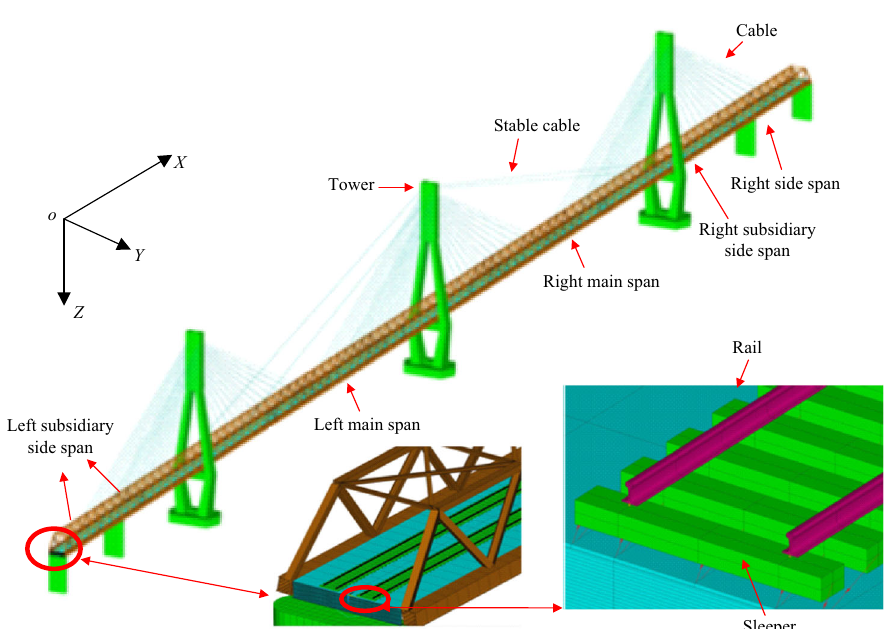
Fig. 6 Three-dimensional finite element model of the